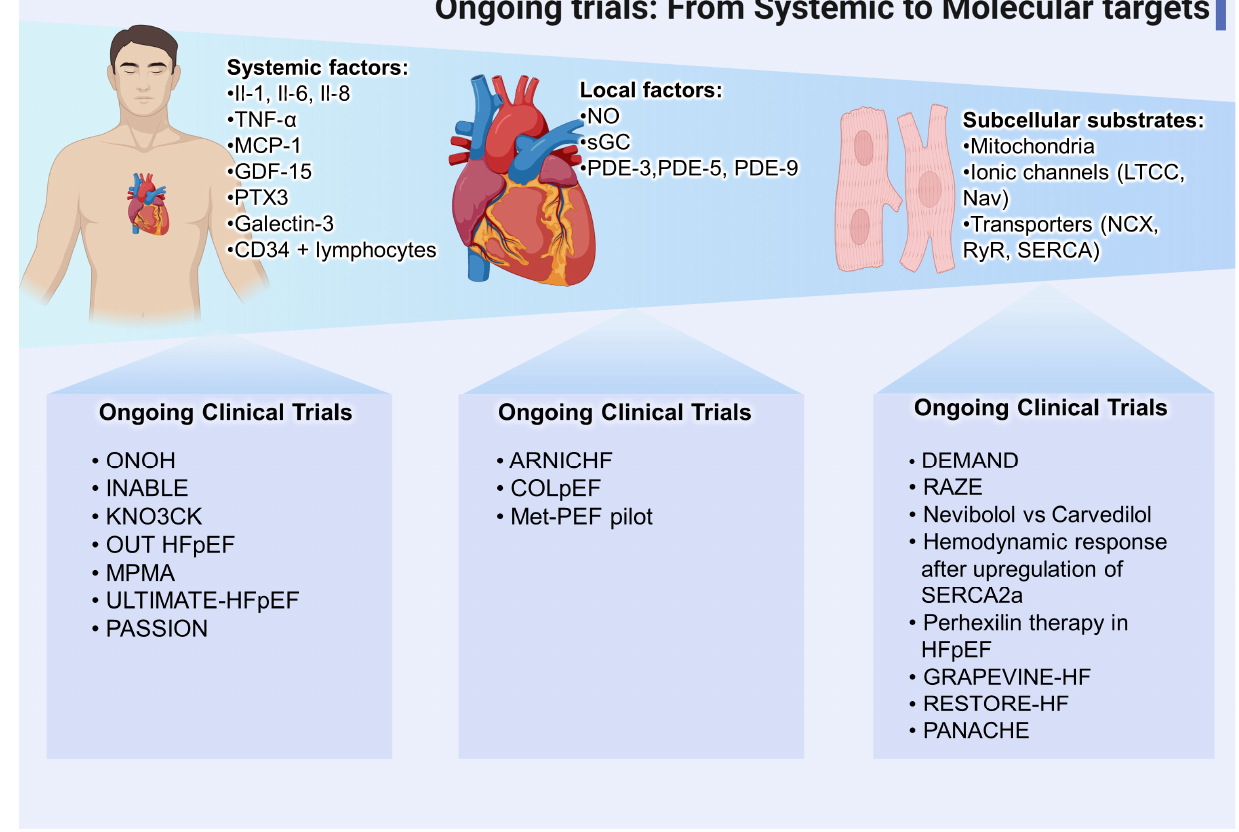
Figure 2. Ongoing clinical trials in HFpEF. Summary of several clinical trials not finished or awaiting results for different levels in the pathophysiology of HFpEF. (IL = interleukin; TNF = tumor necrosis factor; MCP = monocyte chemoattractant protein; GDF = growth differentiation factor; PTX = pentraxine; NO = nitric oxide; sGC = soluble guanylyl cyclase; PDE = phosphodiesterase; LTCC = L ‐ type calcium channel; Nav = voltage ‐ gated sodium channels; NCX = Na + ‐ Ca 2+ exchanger; RyR = ryanodine receptor; SERCA = sarco/endoplasmic reticulum Ca 2+ ‐ ATPase) (created with Biorender).